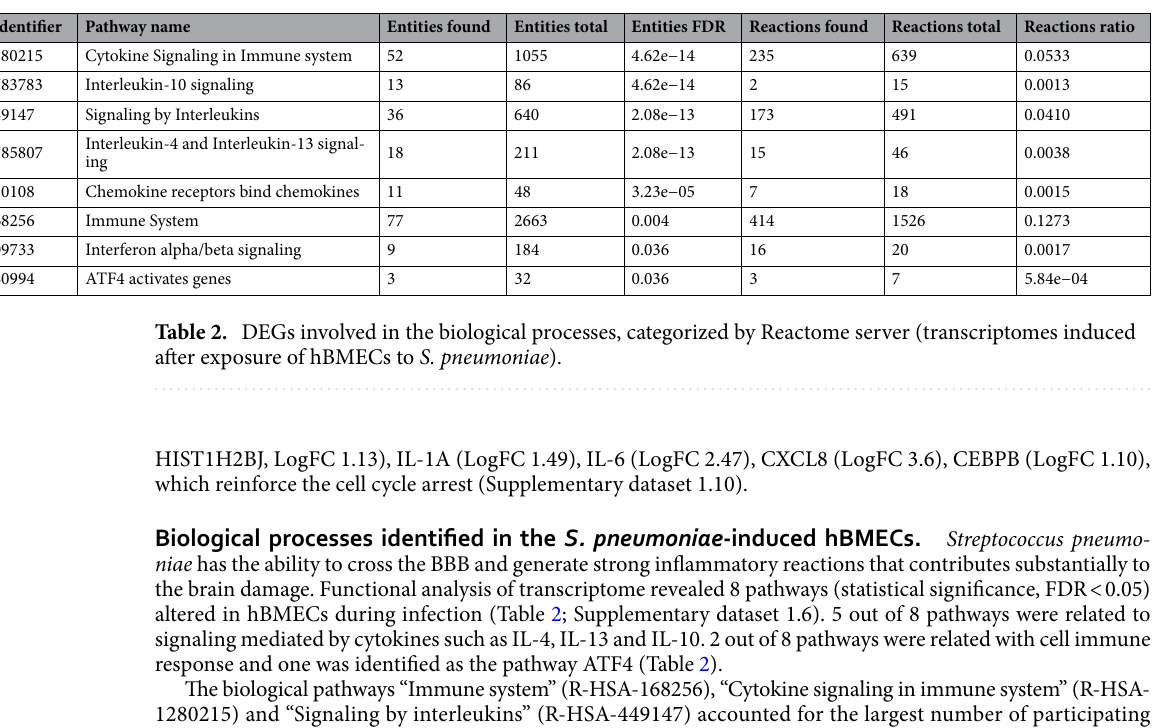
Figure 2. Validation of DEGs with qRT-PCR. (Panel A ) Correlation of the gene expression (LogFC) of DEGs obtained from RNA-seq and qRT-PCR after incubation of hBMECs with S. pneumoniae. (Panel B ) Correlation of the gene expression (LogFC) of DEGs obtained from RNA-seq and qRT-PCR after incubation of hBMECs with Lbp. (Panel C ). Gene expression (LogFC) of DEGs used to validate RNA-seq analysis of induced hBMECs ( S. pneumoniae or Lbp). Black bars—LogFC values from RNA-seq, white bars—LogFC calculated from qRT- PCR.